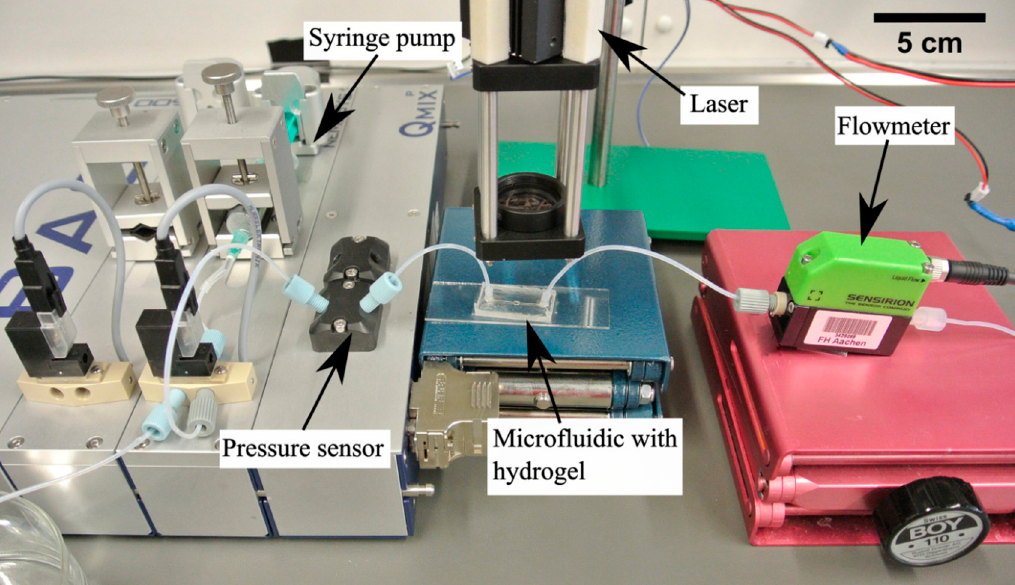
Figure 1. Setup for the characterization of the valve functionality including a laser for the stimulation of the hydrogels, a syringe pump to generate the required flow and a pressure sensor and a flowmeter to record the relevant parameters within the